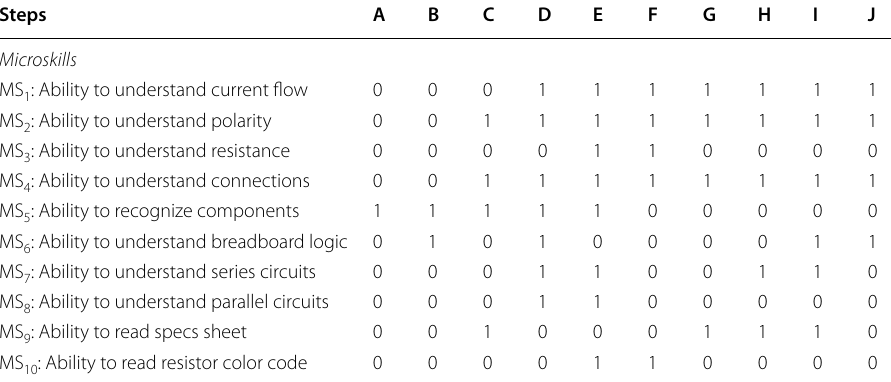
Table 3 Prepared Q-matrix for all selected tasks